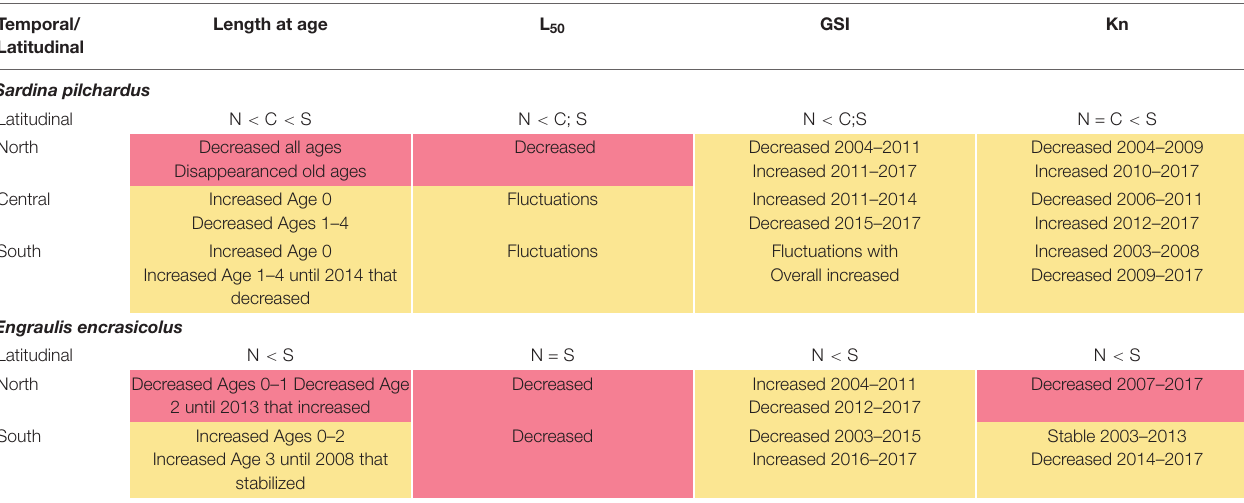
FIGURE 8 | Partial GAM plots for body condition index (Kn) of anchovy ( Engraulis encrasicolus ) for each area; (A) North (purple) and (B) South (yellow). Significant partial effects of meridional current (MC), zonal currents (ZC), average sea temperature of 150 m (ST-150) and net primary production (NPP), are represented. The shaded areas indicate the 95% confidence interval. TABLE 2 | Summary table of the main trends observed for each life history trait studied; length at age, length at maturity (L 50 ), gonadosomatic index (GSI) and body condition index (Kn), for sardine ( Sardina pilchardus ) and anchovy ( Engraulis encrasicolus ) in the western Mediterranean